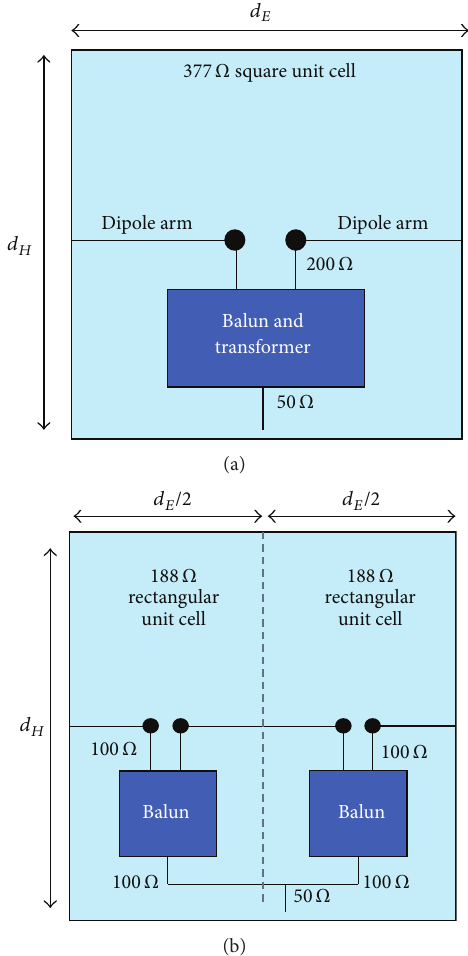
Figure 6: Impedance of array unit cell is proportional to the aspect ratio of 𝑑 𝐸 /𝑑 𝐻 . Splitting the cell vertically into two halves, the impedance is reduced by a factor of two. Combining the halves in parallel reduces the impedance by another factor of two (power divider from 50 Ω to 100 Ω ). (a) Square 377 Ω unit cell and (b) two 188 Ω “half” unit cells from [48].